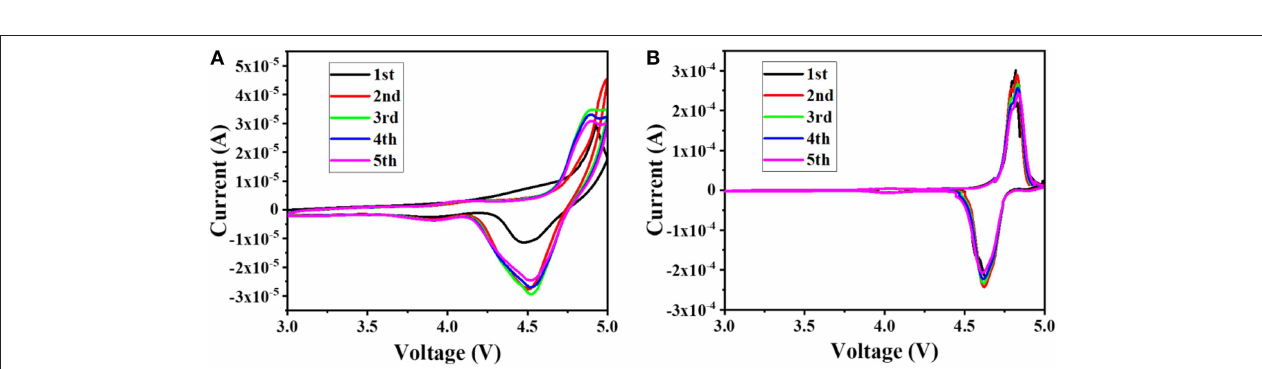
FIGURE 2 | Impedance spectrum of LNMO/Li cells: (A) after 1 cycle; (B) the first three cycles with 0.5 wt.% PTSI; (C) the first three cycles with no additive.